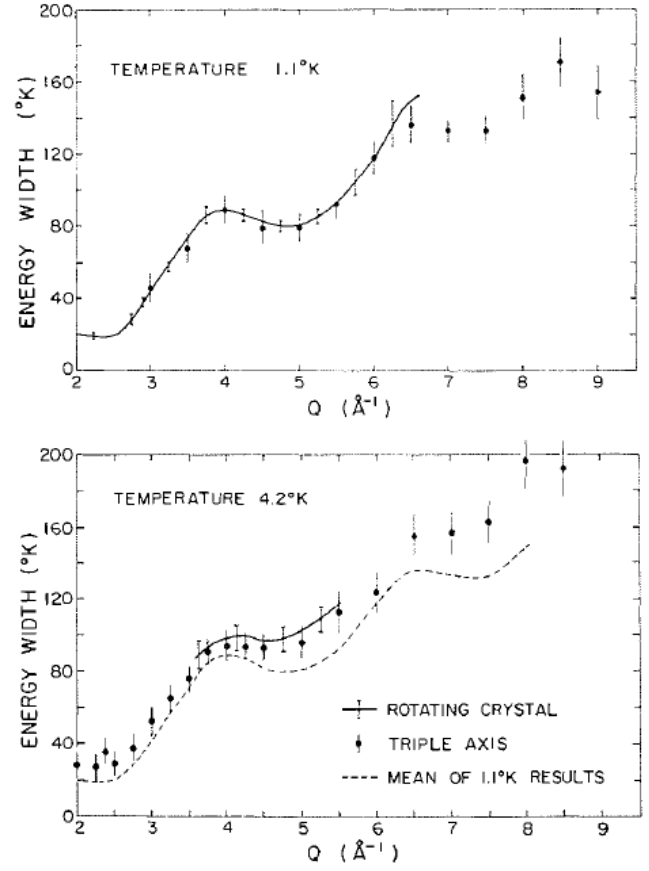
Figure 44. The width of the broad multiphonon peak in the scattering at large. Q in liquid helium as given by the width at half height at 1.1 and 4.2 K. This figure is taken from Figure 22 of ref. [105] courtesy of Canadian Science Publishing and its licensors.